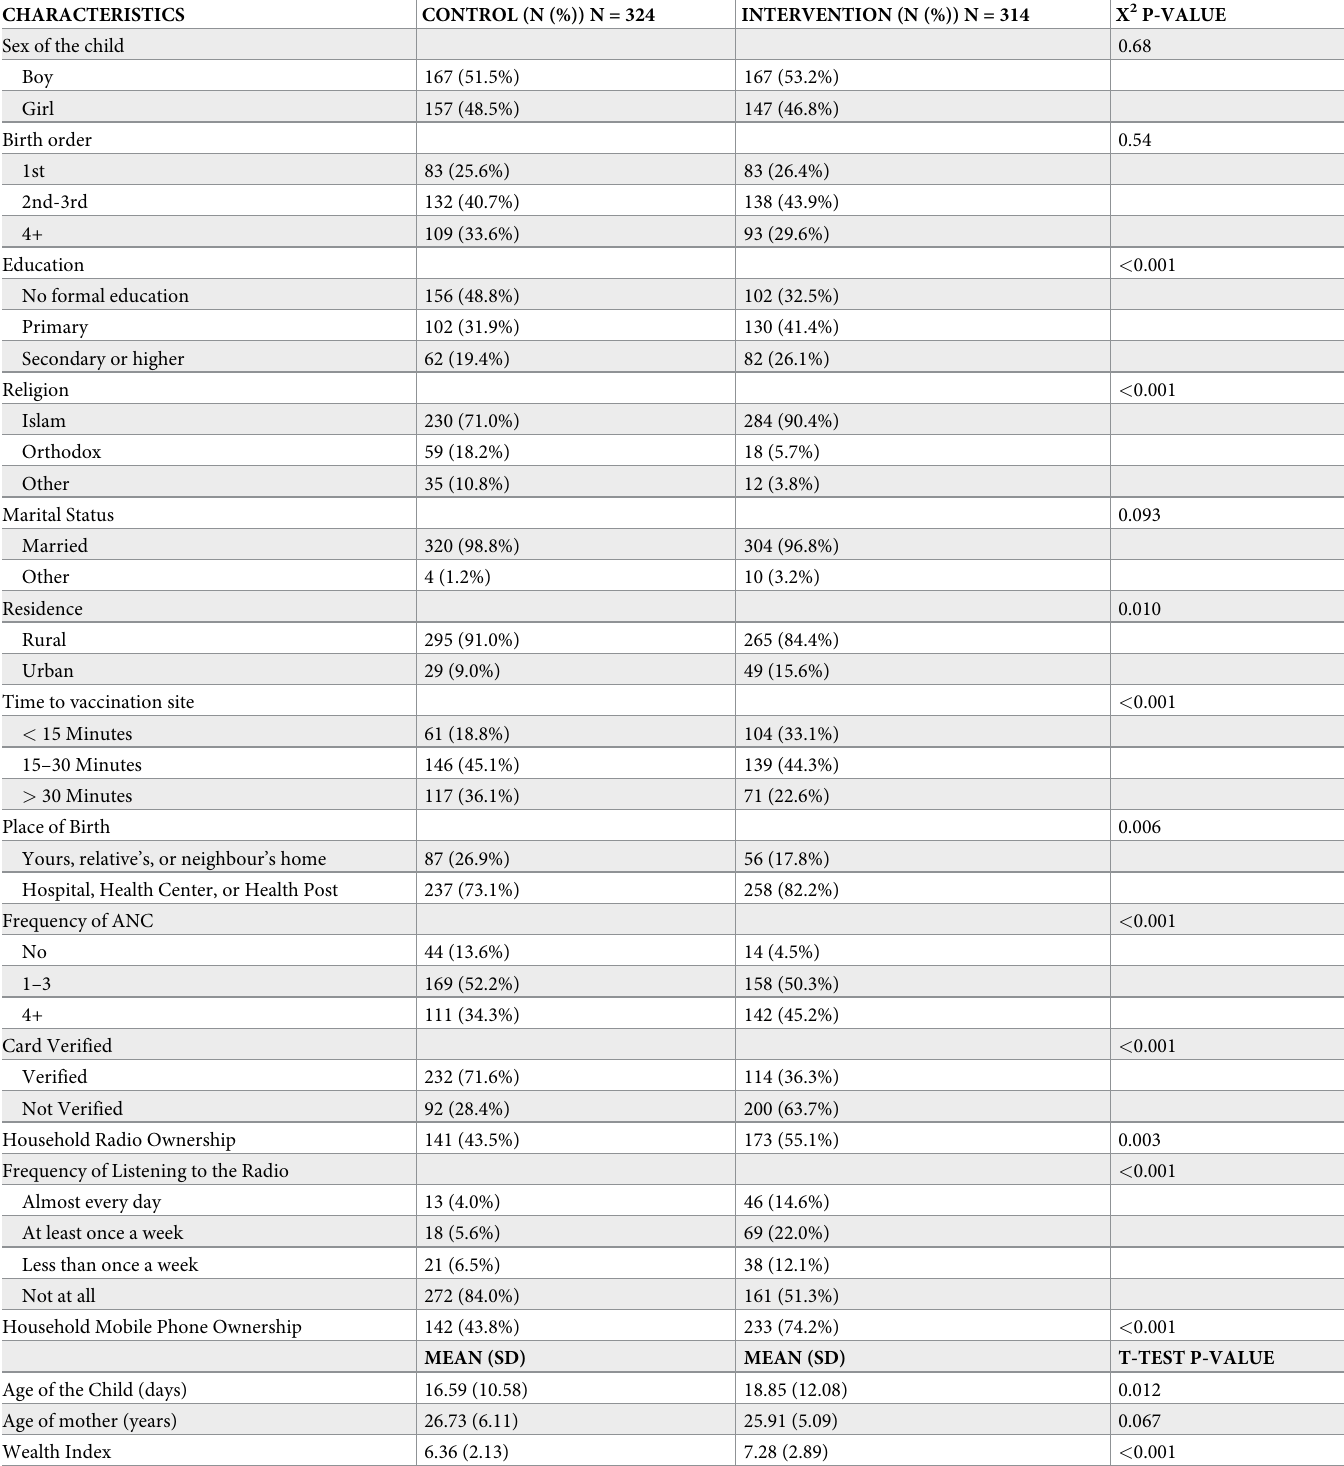
Table 1. Baseline characteristics of the participants in the intention to treat analysis.